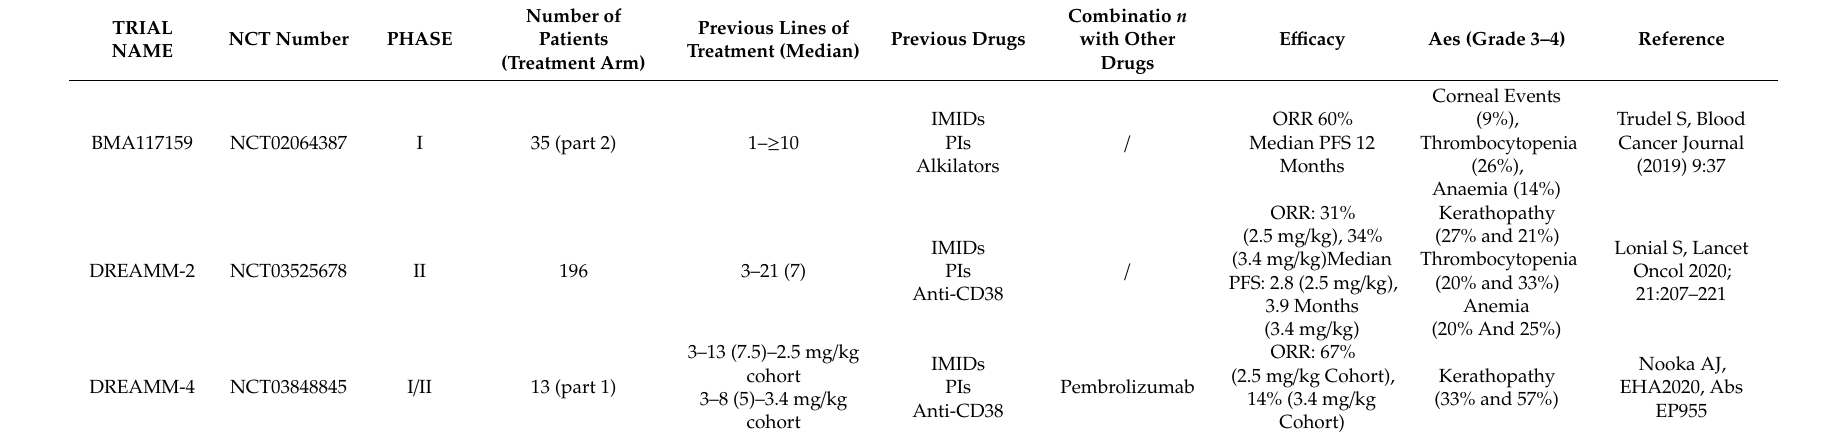
Table 1. Preliminary results of main clinical trials with GSK2857916 (Belantamab Mafodotin).